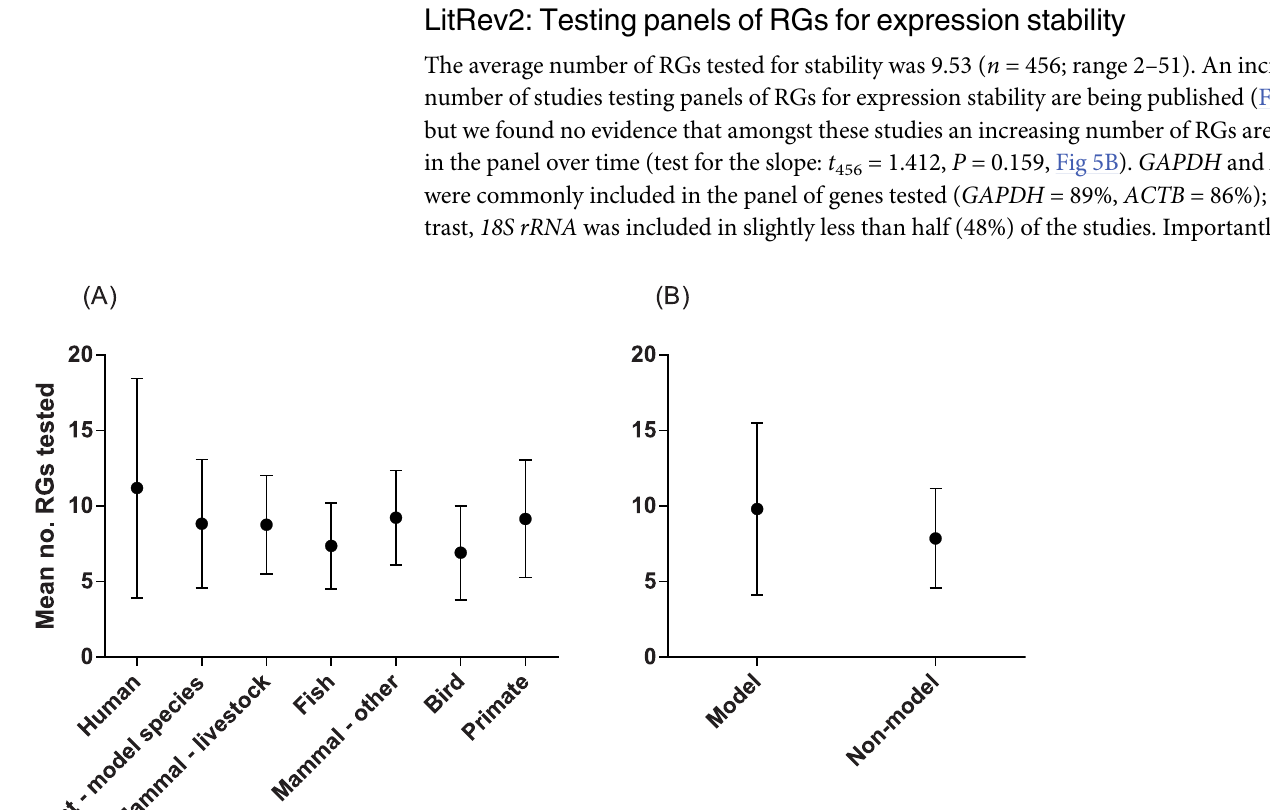
PLOS ONE | DOI:10.1371/journal.pone.0141853 November 10,